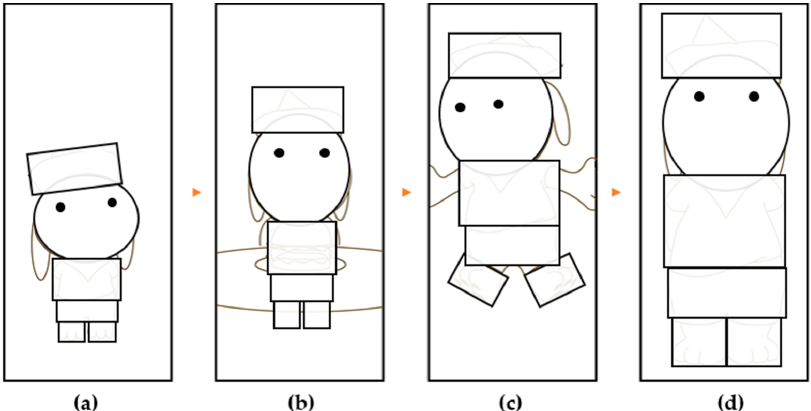
Figure 2. Growth level example of the synthetic animal character’s scale level as: ( a ) 1st Level. Infant; ( b ) second level. elementary school student; ( c ) third level. teenager; and ( d ) fourth level. adult. In order for synthetic animals to go through the levels ( a – d ), they should be provided with food, play, bathing, and so on in their